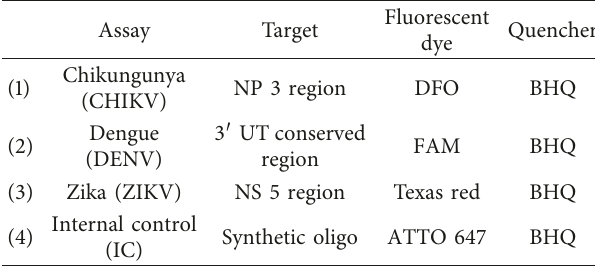
Table 3: Details of the rRT-PCR assay used in testing for CHIKV, DENV, and ZIKV, including the genome regions targeted, the fluorescent dyes, and the quencher.